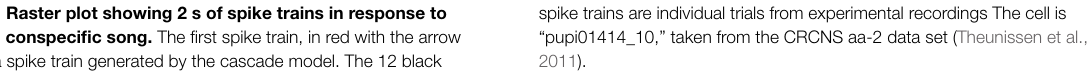
FIGURE 10 | Raster plot showing 2 s of spike trains in response to Zebra Finch conspecific song. The first spike train, in red with the arrow next to it, is a spike train generated by the cascade model. The 12 black